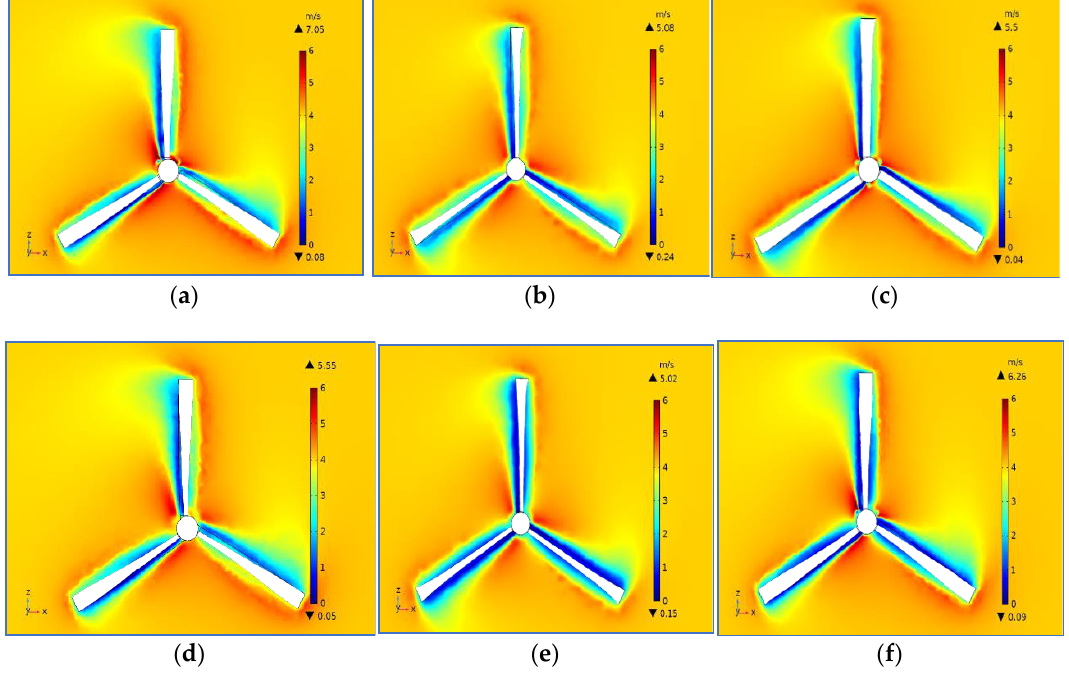
Figure 13. Velocity profiles of the flow surrounding the rotating turbine for ( a ) Fit A, ( b ) Fit B, ( c ) Fit C, ( d ) Fit D, ( e ) Fit E, and ( f ) Fit F.